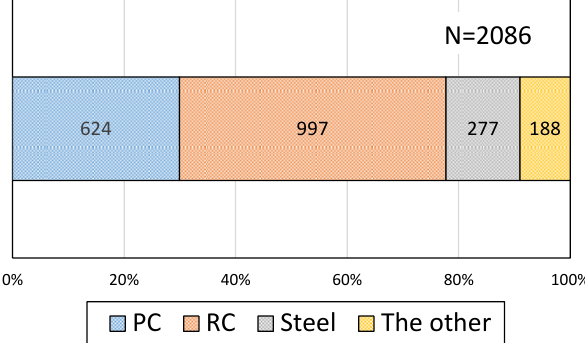
Figure 2. Share of superstructure materials for bridges in Ishikawa Prefecture.